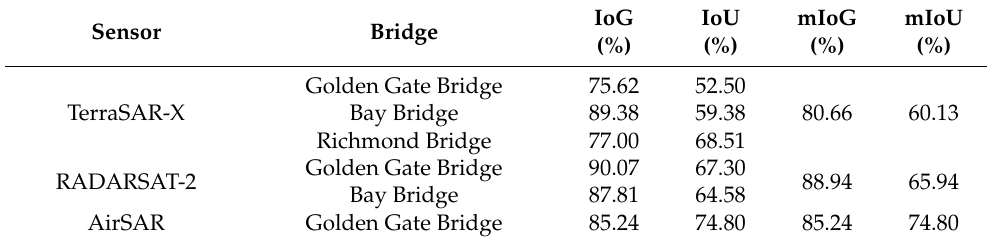
Table 3. Detection performances of each bridge in the San Francisco region under different bands, where mIoG denotes the average intersection over ground-truth value. mIoU denotes the average intersection over